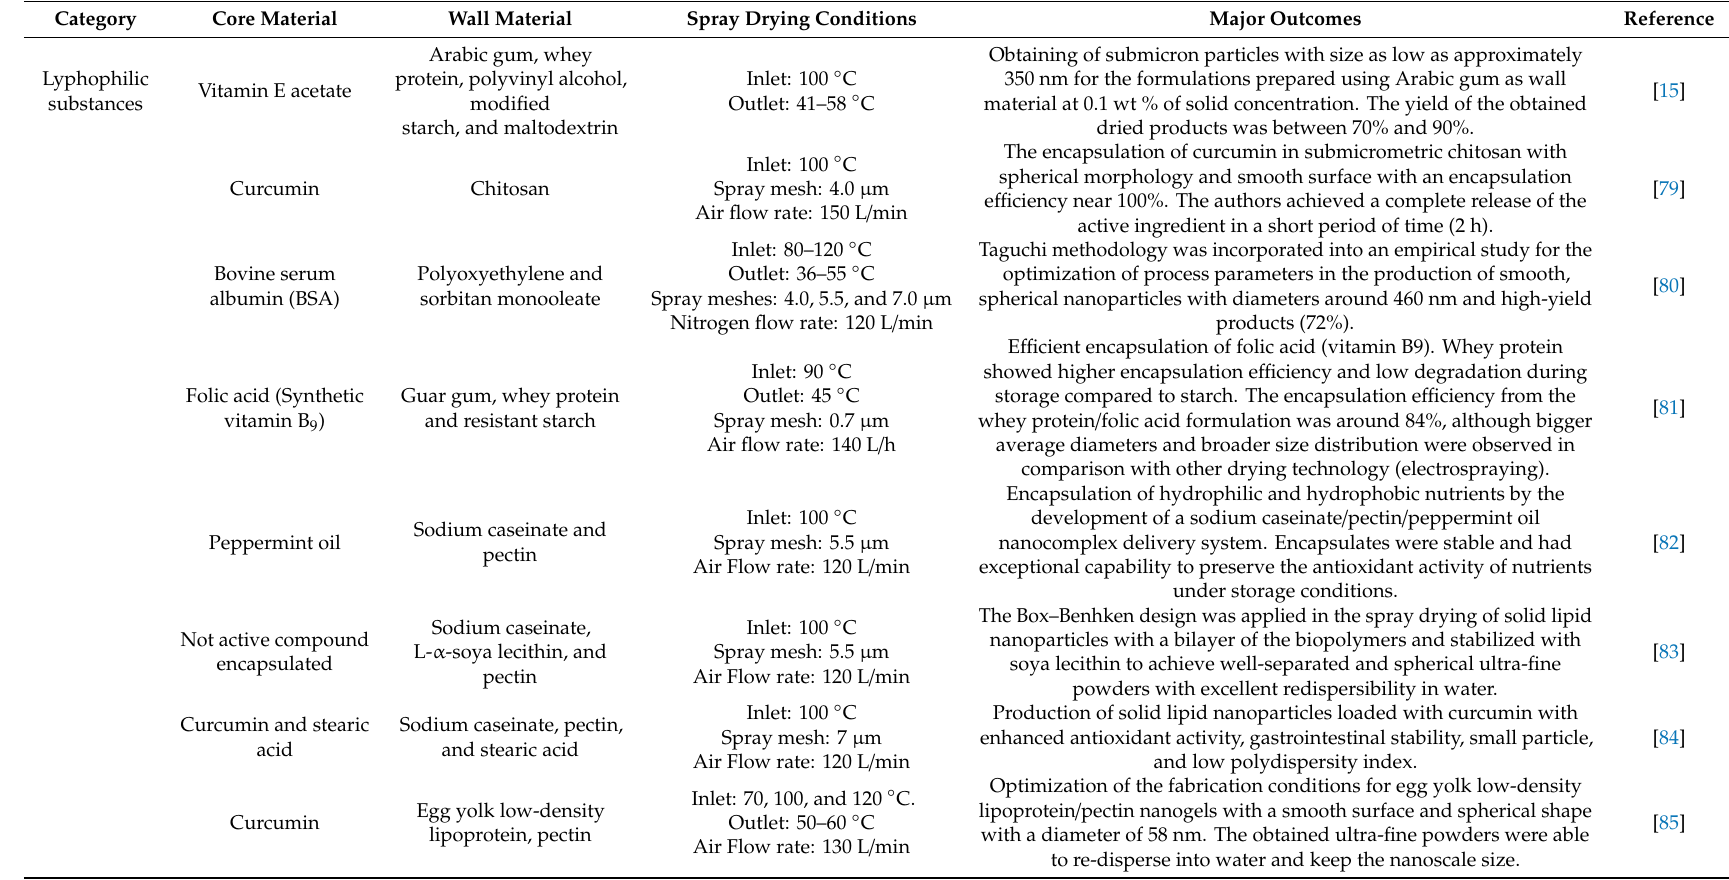
Table 2. Summary of protection of bioactive ingredients employing a nano spray-drying